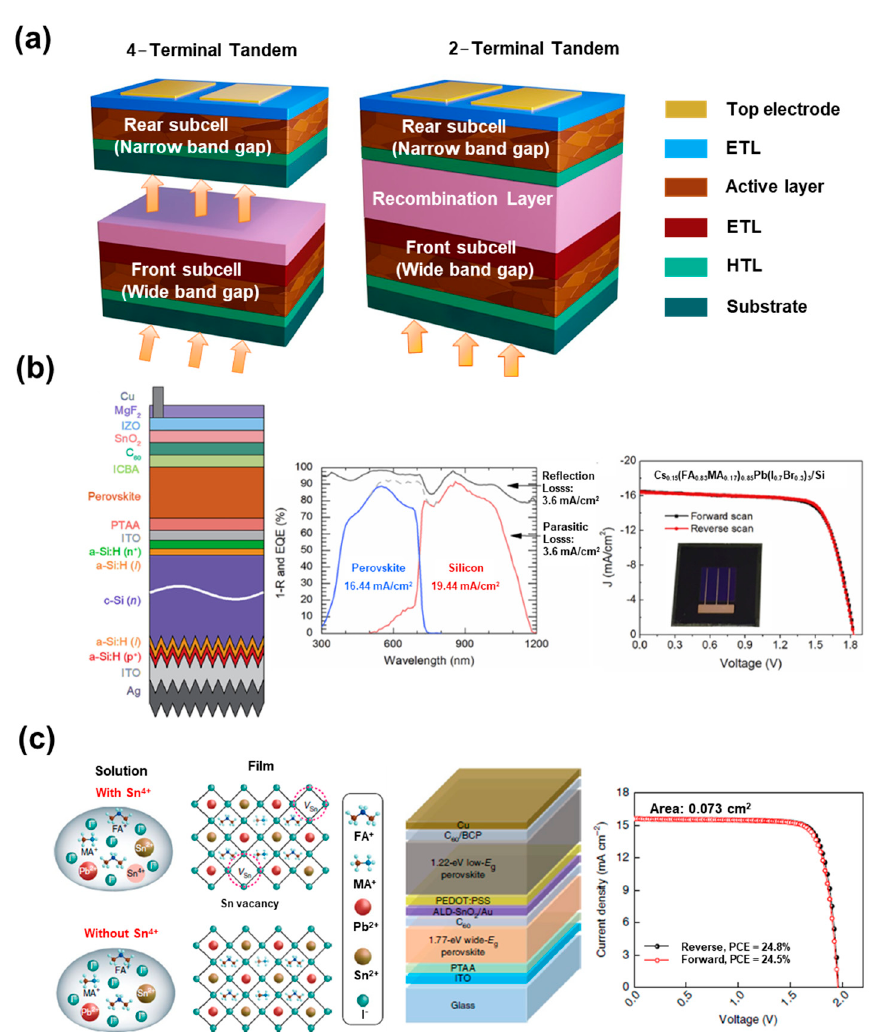
Figure 7. ( a ) Schematic illustration for 4–terminal and 2–terminal perovskite–based tandem struc- ture. ( b ) Schematic structure for perovskite–silicon monolithic tandem devices, J–V curves of perovskite–Si tandem device under forward and reverse scans with an inset photograph of the tandem device, and EQE and total absorbance of perovskite–Si tandem device. ( c ) Schematic of the formation of Sn vacancies in mixed Sn–Pb perovskite along with device architecture and J–V curves of the tandem solar cell. ( c ) Schematic illustration of planar heterojunction PSCs, energy-level diagram for NBG perovskite and different fullerene derivatives, and current density–voltage (J–V) characteristics of champion devices. Reprinted with permission from Refs. [145,154].